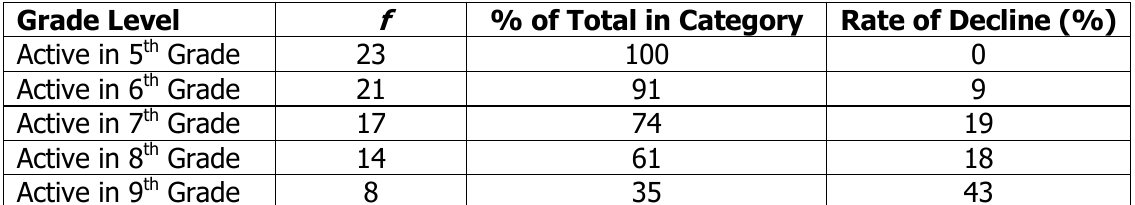
4-H Club Participation by Grade Level (N =